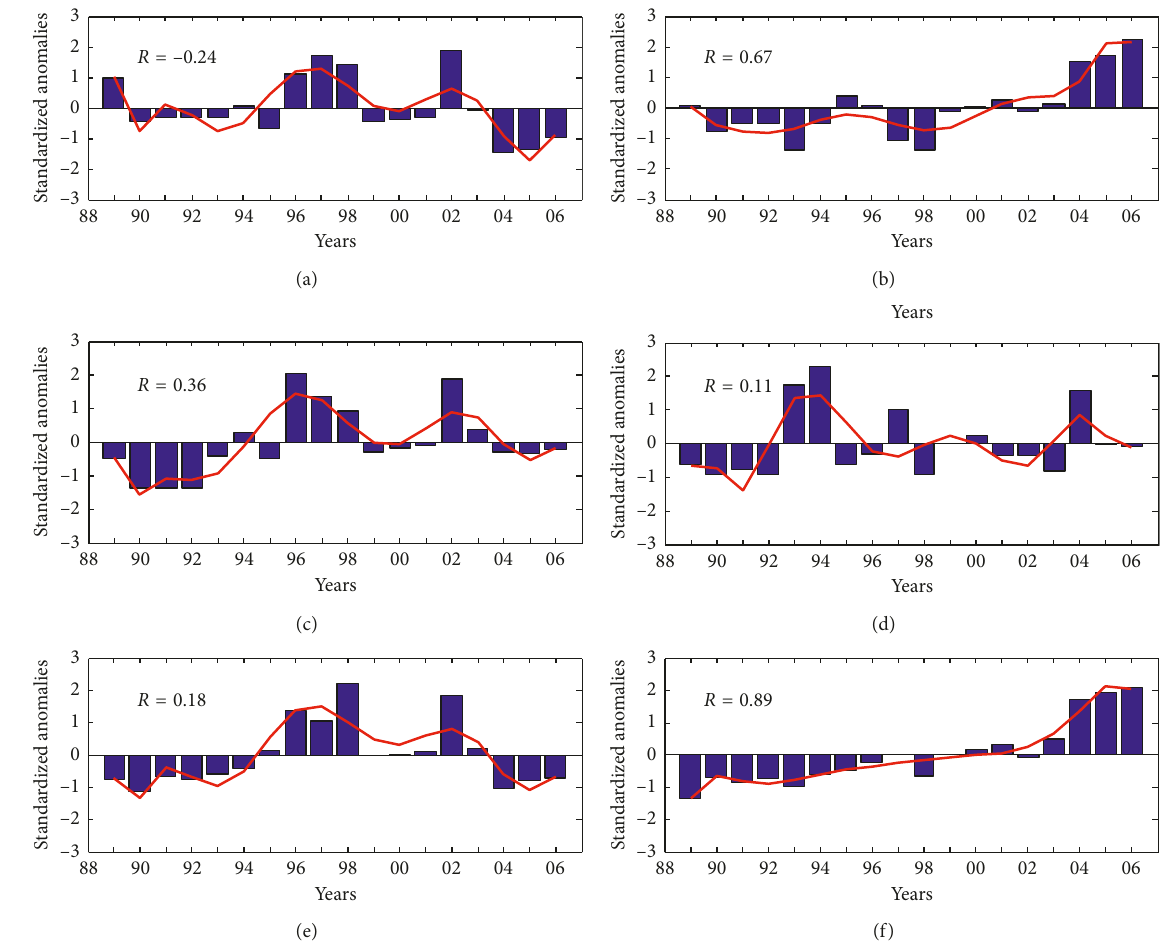
Figure 3: Standardized anomalies of cocoa production in the six reference departments of the study area during the 1989–2006 period. Red line indicates the trend curve. (a) Abengourou. (b) Agboville. (c) Daloa. (d) Dimbokro. (e) Guiglo. (f)